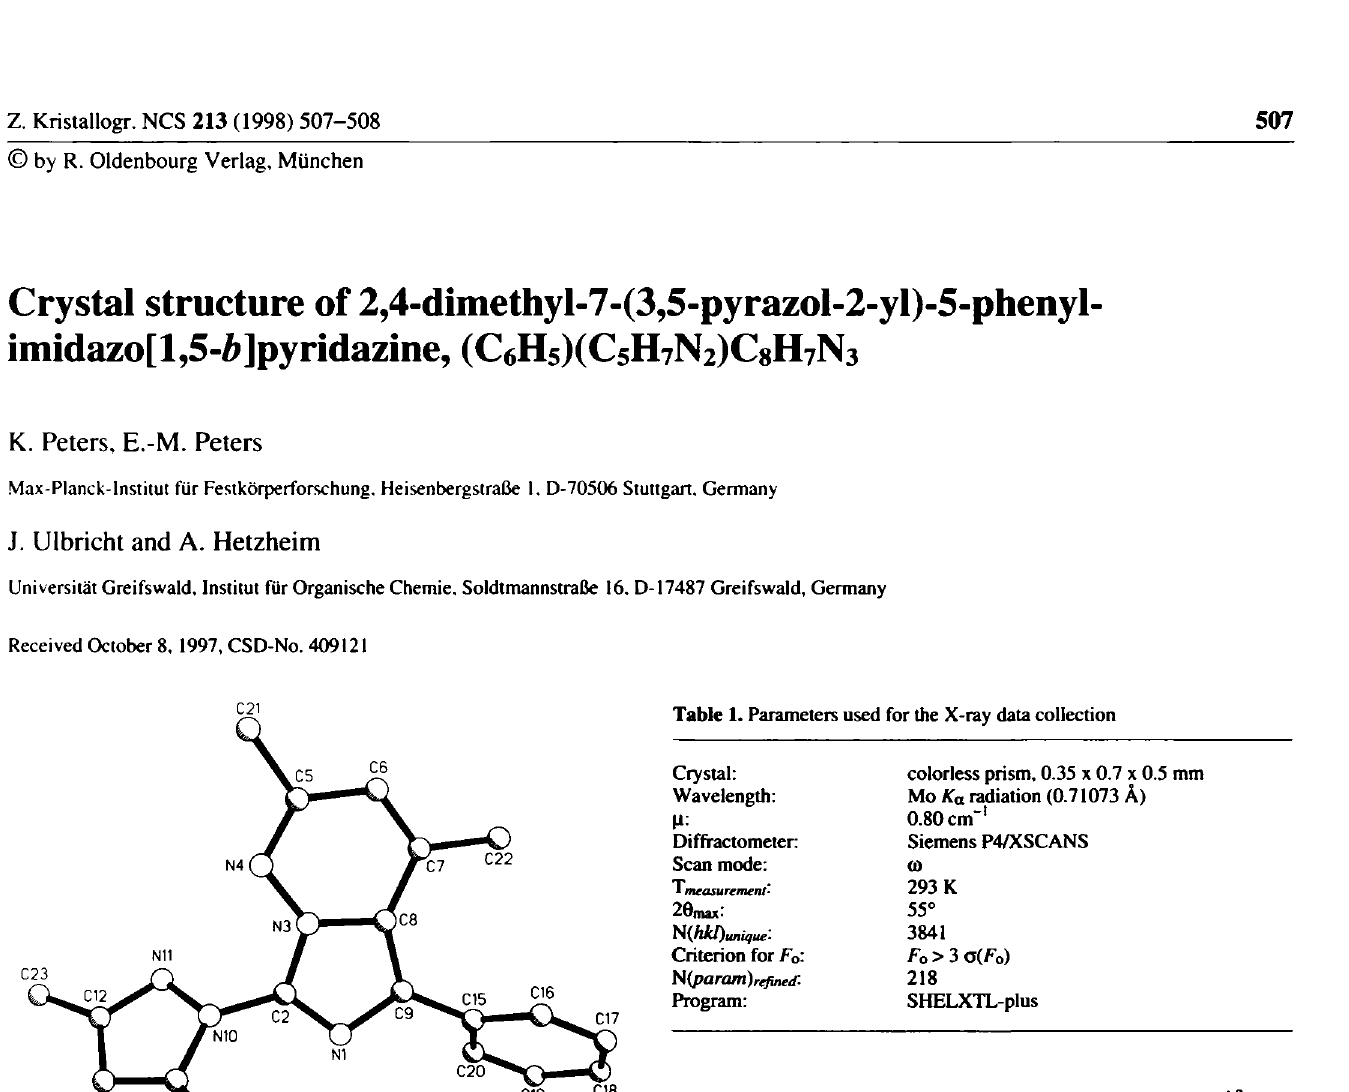
Table 2. Final atomic coordinates and displacement parameters (in Â^)